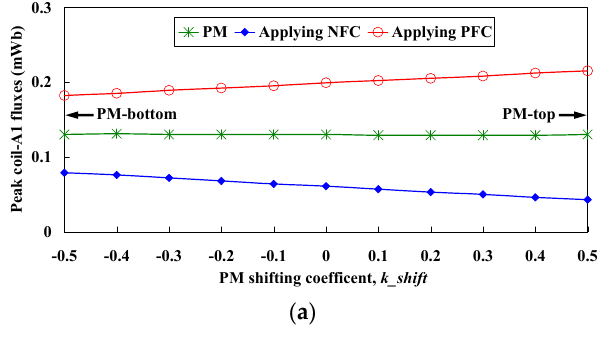
Figure 11. Cont. Figure 11.